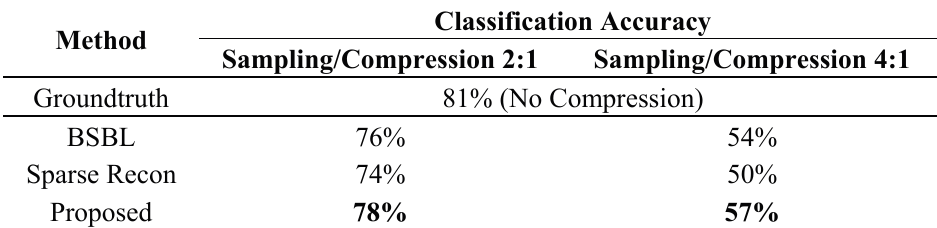
Table 3. Classification accuracy in